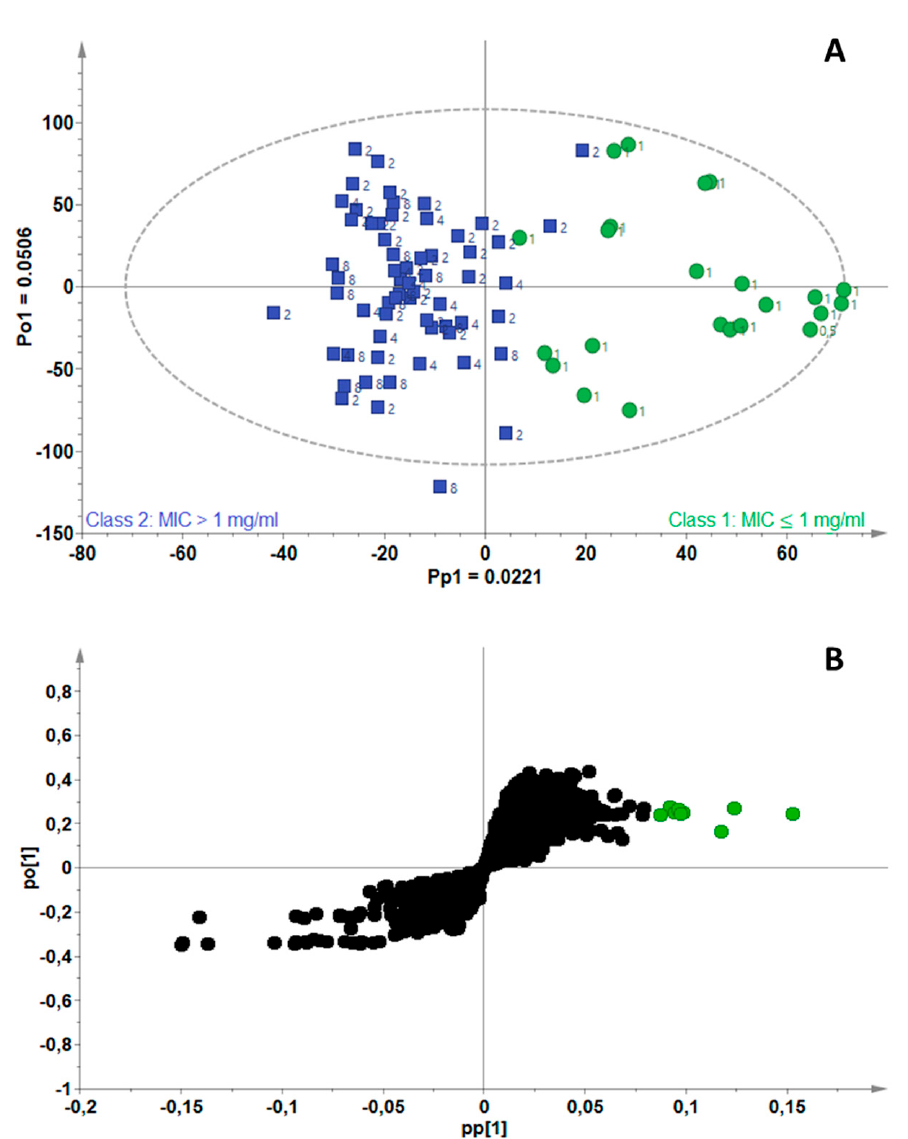
Figure 2. ( A ) OPLS-DA scores scatterplot for Mycobacterium smegmatis , showing separation of active (green) and non-active (blue) essential oils, ( B ) S-plot of the variables, indicating the putative biomarkers (green) associated with essential oils active against M. smegmatis . Figure 3A is the scores scatterplot for M. fortuitum , where separation of the active (green) from non-active (blue) EOs can be observed along the predictive component (Pp1), with 2.65% chemical variation related to separation of the two groups. The model fitted with one predictive and two orthogonal components (A = 1 + 2) was computed using 11.7% (R 2 X cum = 0.11) of the total variance in the X-matrix and the total variation explained in the Y-matrix was 79.2% (R 2 Y cum = 0.79). Tentative identification of the RTM pairs filtered in the S-plot (Figure 3B) revealed the biomarkers associated with the EOs active towards M. fortuitum to be linalool, geranial, geranyl butyrate, cinnamaldehyde, eugenol and thymol. Two compounds that were previously identified as biomarkers in Figure 3B, were also filtered out for M. fortuitum ; these were identified as thymol and geranyl